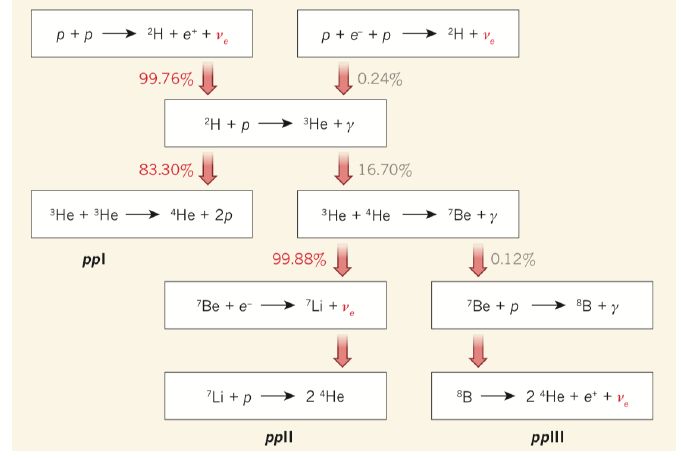
Figure 1: The solar pp fusion chain.